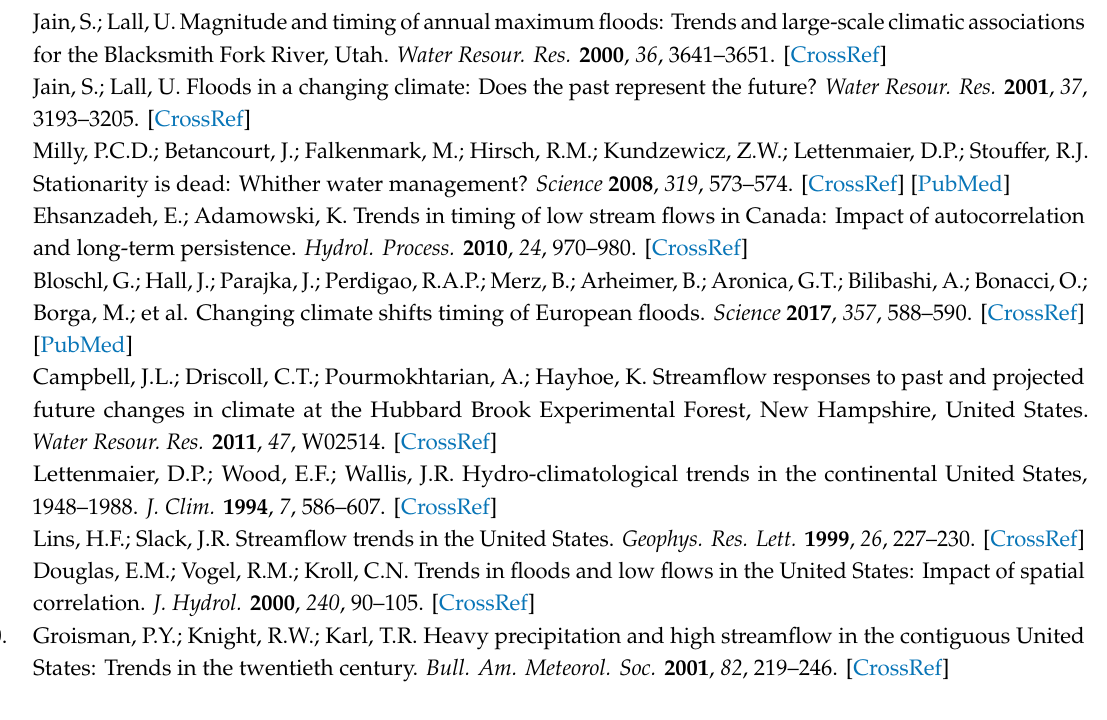
Figure S1: A map of the study region showing the geographical extend of the Northeast–Midwest (NE–MW) region and locations of the basins selected for the study, Figure S2: Assessment of temporal changes in seasonality of daily annual maximum streamflow (AMF) based on mean ( θ ) and variability ( ρ ); (a) frequency of climate stations with similar θ of AMF for the period 1951-1980; (b) frequency of climate stations with similar θ of AMF for the period 1981- 2010; (c) frequency of climate stations with similar ρ of AMF for the period 1951-1980; (d) frequency of climate stations with similar ρ of AMF for the period 1981-